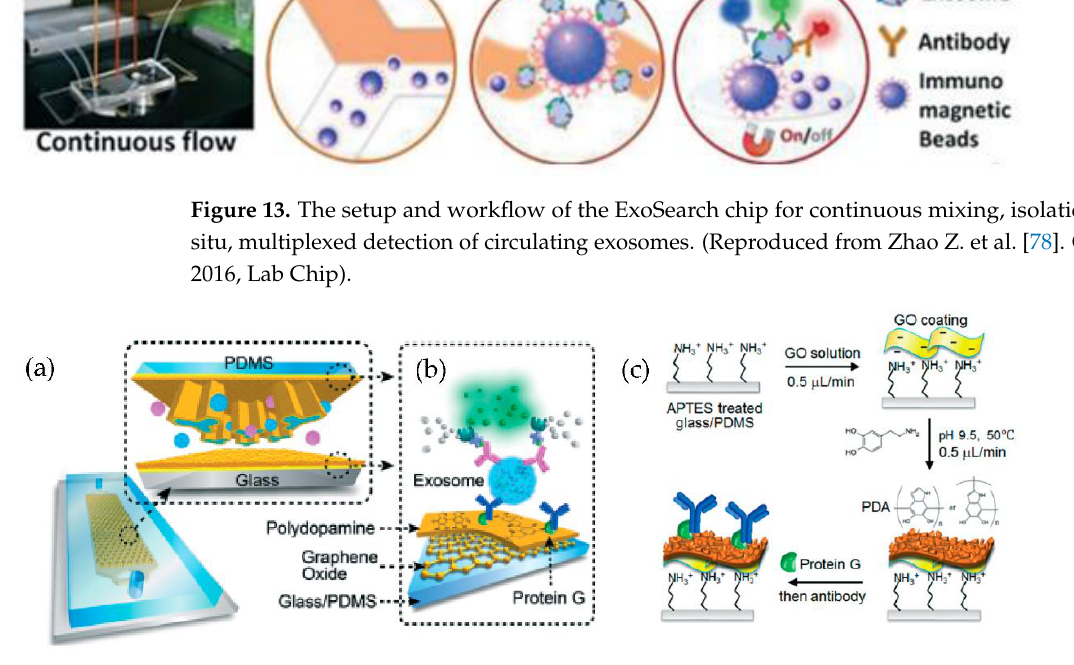
Figure 14. Nano-interfaced microfluidic exosome platform (nano-IMEX). ( a ) Schematic of a single- channel PDMS/glass device, with the exploded-view highlighting the coated PDMS chip containing an array of Y-shaped microposts. ( b ) Schematic showing the surface of the channel and microposts coated with graphene oxide (GO) and polydopamine (PDA). ( c ) The protocol involved in the surface functionalization of the microfluidic chips. (Reproduced from Zhang P. et al. [79]. Copyright 2016, Lab Chip).